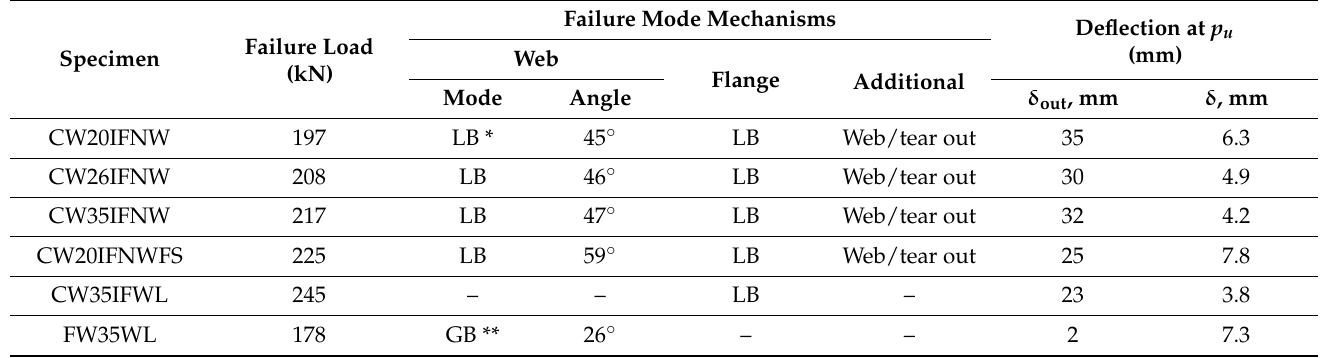
Table 3. Experimental test